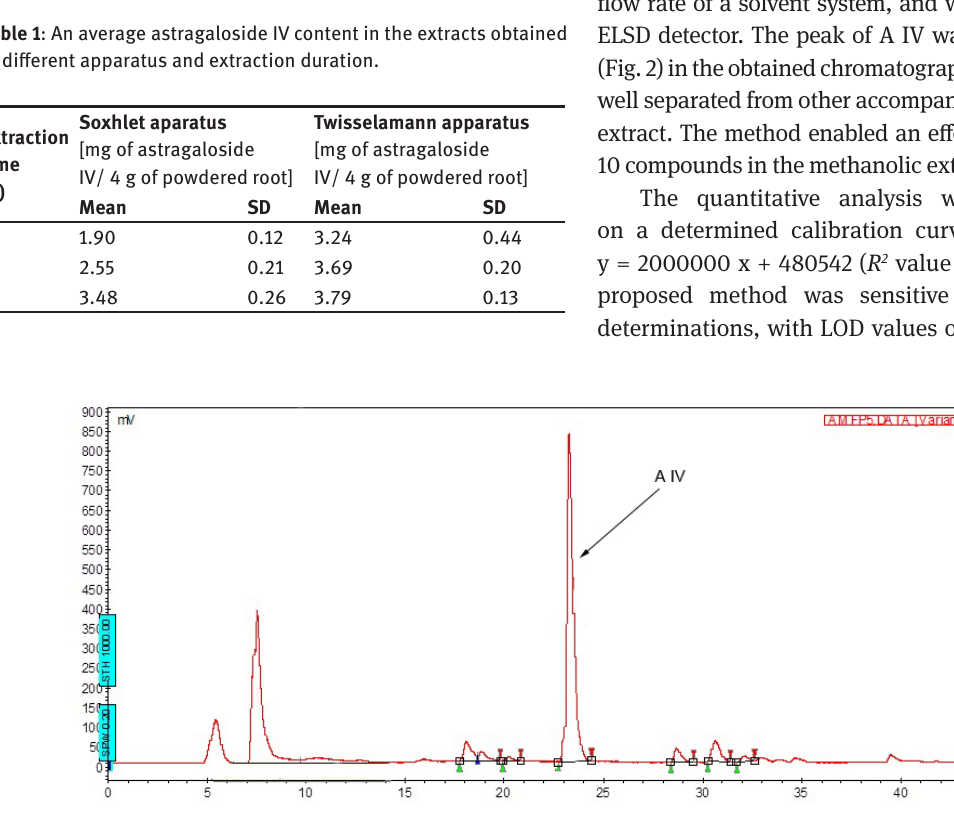
Figure 2: ELSD chromatogram of Astragalus mongholicus root extracts with astragaloside IV at 23.5